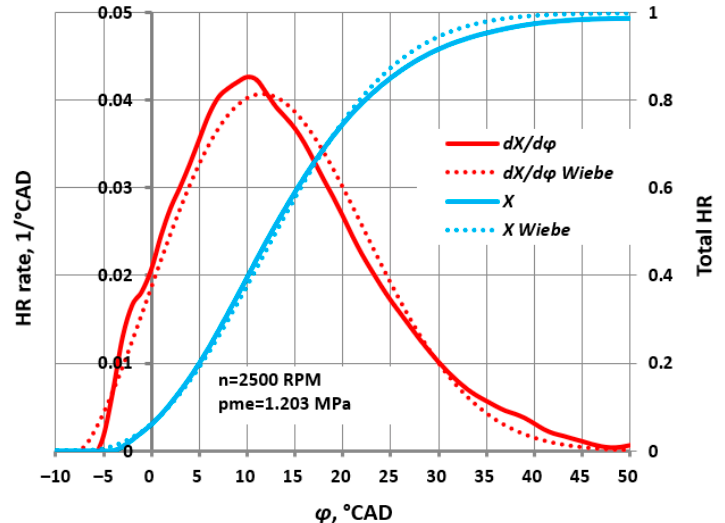
Figure 3. The characteristics (real and calculated by Wiebe function) of heat release and total fuel